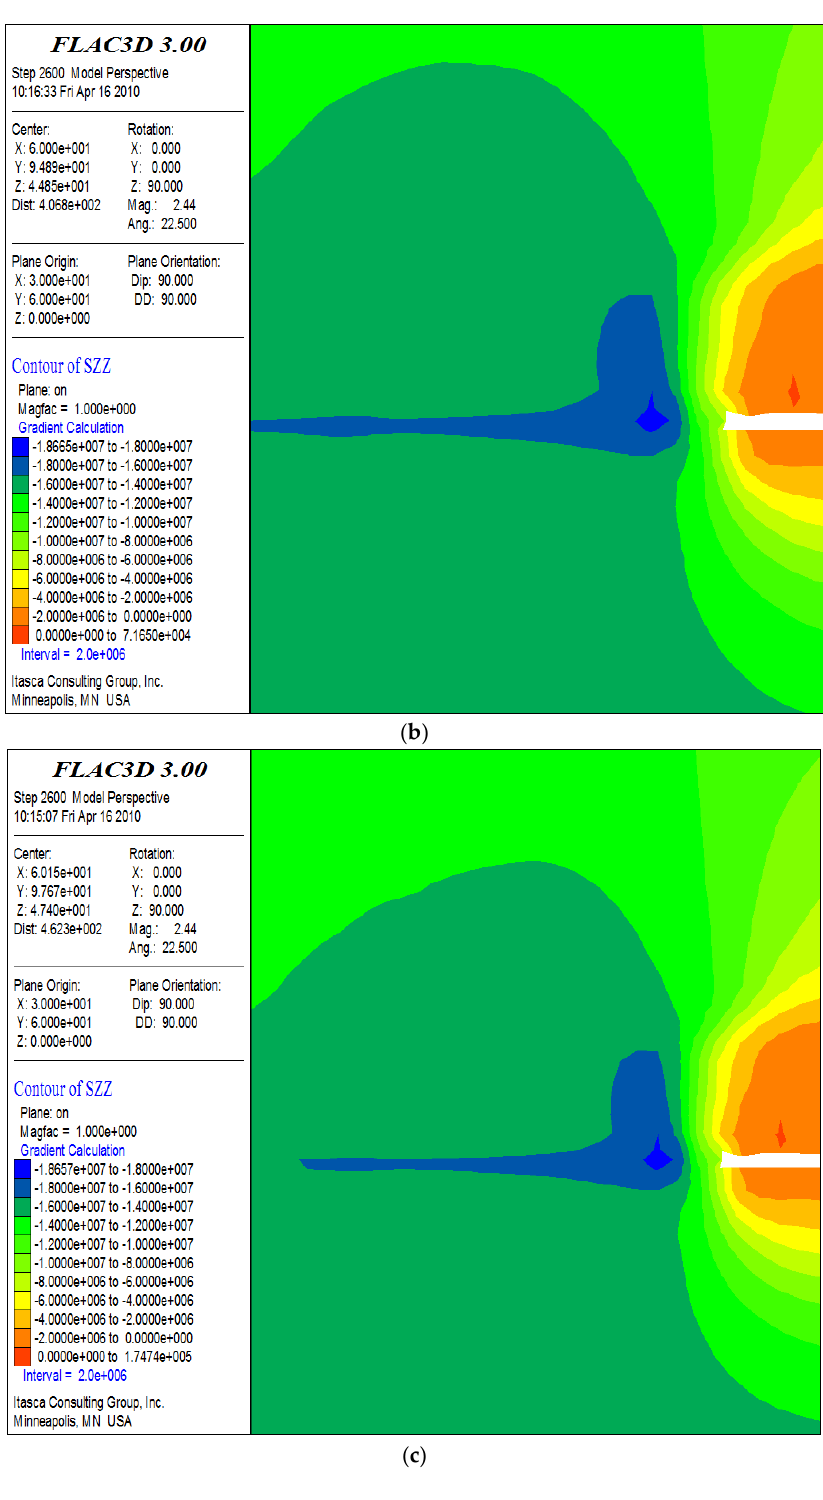
Figure 15. Simulation of stress distribution under different number of boreholes: ( a ) one; ( b ) two and ( c ) three.